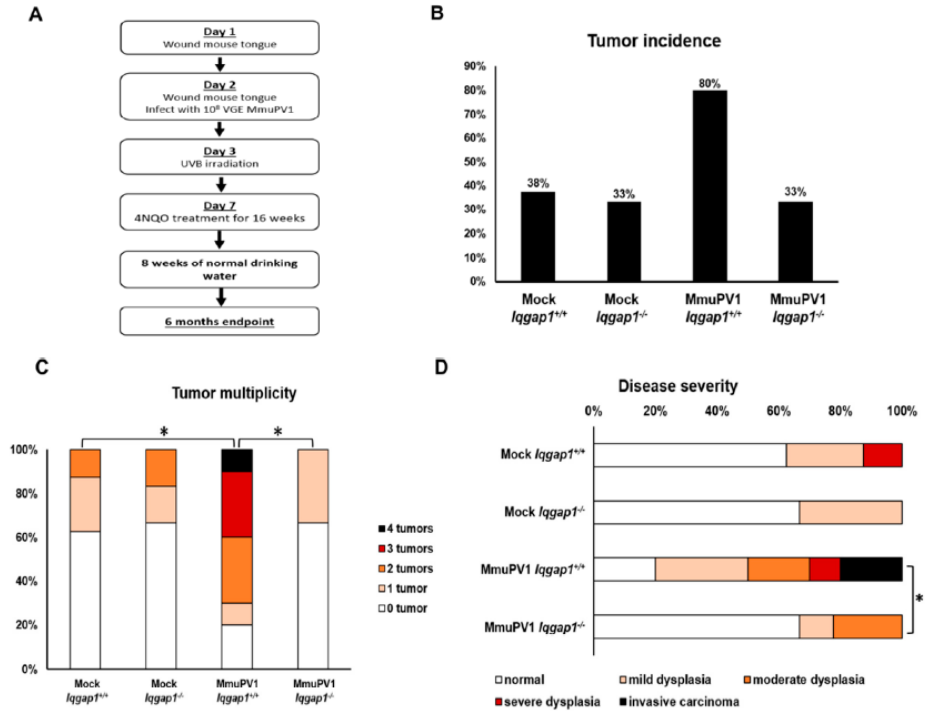
Figure 3. IQGAP1 contributes to MmuPV1-induced head and neck tumorigenesis. ( A ) Overview of experimental protocol for MmuPV1 infection of tongue tissue in Iqgap1 +/+ and Iqgap1 − / − mice. ( B ) Tumor incidence in each experimental group at 6 months post-infection. Statistical analysis was performed with the two-sided Fisher’s exact test: MmuPV1-infected Iqgap1 +/+ vs. mock-infected Iqgap1 +/+ , p = 0.14; MmuPV1-infected Iqgap1 +/+ vs. MmuPV1-infected Iqgap1 − / − , p = 0.069; mock- infected Iqgap1 +/+ vs. mock-infected Iqgap1 − / − , p = 1; mock-infected Iqgap1 − / − vs. MmuPV1-infected Iqgap1 − / − , p = 1, two-sided Fisher’s exact test. ( C ) Tumor multiplicity at 6 months post-MmuPV1 infection. Statistical analysis was performed with the two-sided Wilcoxon rank-sum test: MmuPV1- infected Iqgap1 +/+ vs. mock-infected Iqgap1 +/+ = 2.1 vs. 0.5, p = 0.02; MmuPV1-infected Iqgap1 +/+ vs. MmuPV1-infected Iqgap1 − / − = 2.1 vs. 0.3, p = 0.006. Mock-infected Iqgap1 +/+ vs. mock-infected Iqgap1 − / − , p = 1; mock-infected Iqgap1 − / − vs. MmuPV1-infected Iqgap1 − / − , p = 0.89. ( D ) Disease severity at 6 months post-infection. Statistical analysis was performed with the two-sided Wilcoxon rank-sum test. MmuPV1-infected Iqgap1 +/+ vs. MmuPV1-infected Iqgap1 − / − = 1.8 vs. 0.56, p = 0.04; mock-infected Iqgap1 +/+ vs. mock-infected Iqgap1 − / − = 0.6 vs. 0.3, p = 0.82; MmuPV1-infected Iqgap1 +/+ vs. mock-infected Iqgap1 +/+ =1.8 vs. 0.6, p = 0.06; mock-infected Iqgap1 − / − vs. MmuPV1-infected Iqgap1 − / − = 0.3 vs. 0.56, p = 0.84. Asterisks represent statistical